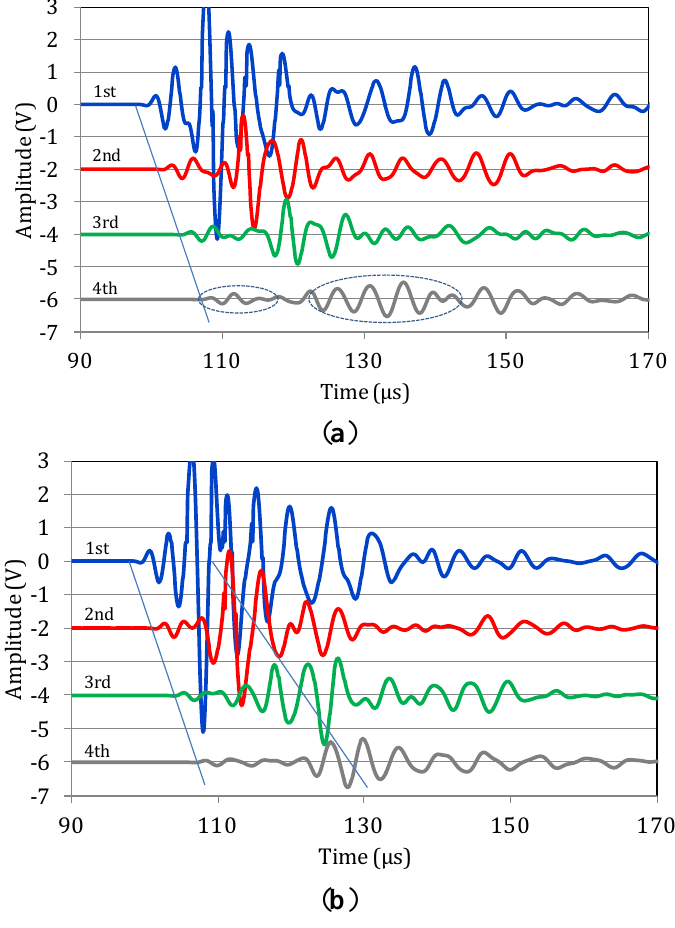
Figure 3. Elastic waveforms on the surface of three different femur bone specimens ( a ), ( b ) and ( c